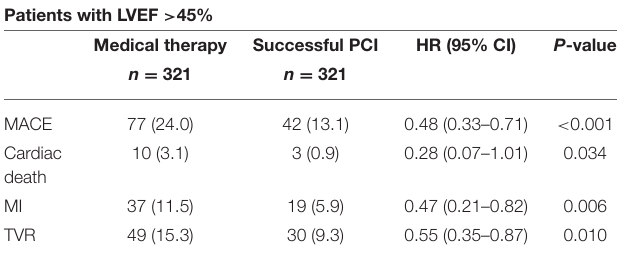
TABLE 5 | Clinical outcomes of propensity-matched patients with and without left ventricular systolic dysfunction stratified according to management. Patients with LVEF > 45%